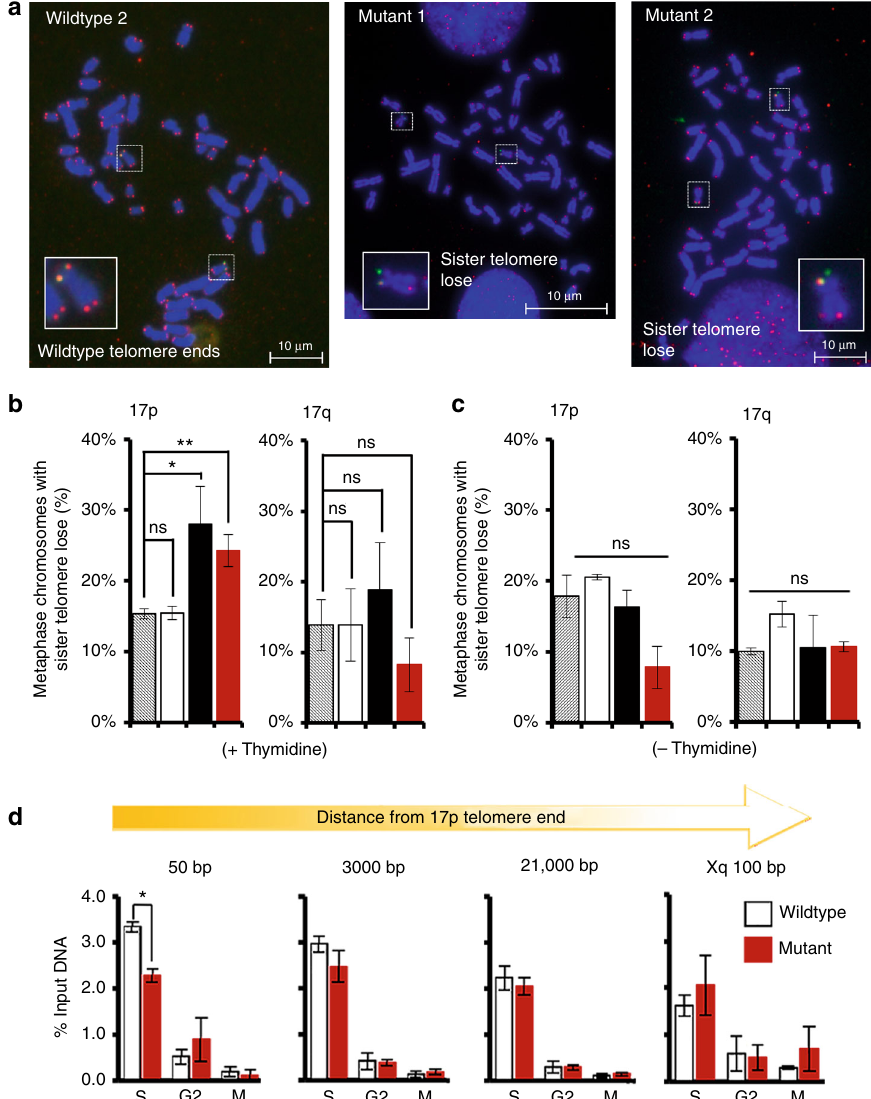
Fig. 3 CTCF site mutant 17p telomere ends exhibit mitotic sister-telomere loss and decreased replication. a Cells were synchronized by double thymidine block, released for 7 h, colcemid was added, and mitotic cells were collected 1 h later. Representative images of mitotic spreads in wildtype 2, Mutant 1, or Mutant 2 clones stained with dual FISH for telomere repeats (red) and 17p subtelomeric sequences (green). Left, wildtype; Center, 17p Mutant 1; Right, 17p Mutant 2. b , c Quanti fi cation of sister-telomere loss on chromosome 17, p and q arms in cells synchronized with double thymidine block (+thymidine) ( b ), or asynchronous cells ( − thymidine) ( c ). Data represented as average of 3 biological replicates, n = 150 – 200 metaphases, error bars represent SEM. * p < 0.05; ** p < 0.01, measured by Student's t test. d Cells were synchronized and released in the presence of BrdU either during the fi rst 6 h, for S phase or from 6 – 8 h for late S/G2, or from 7 – 9 h for M phase. Genomic DNA was isolated and BrdU incorporation was measured by immunoprecipitation with an anti-BrdU antibody. Data represents average of three independent experiments with error in